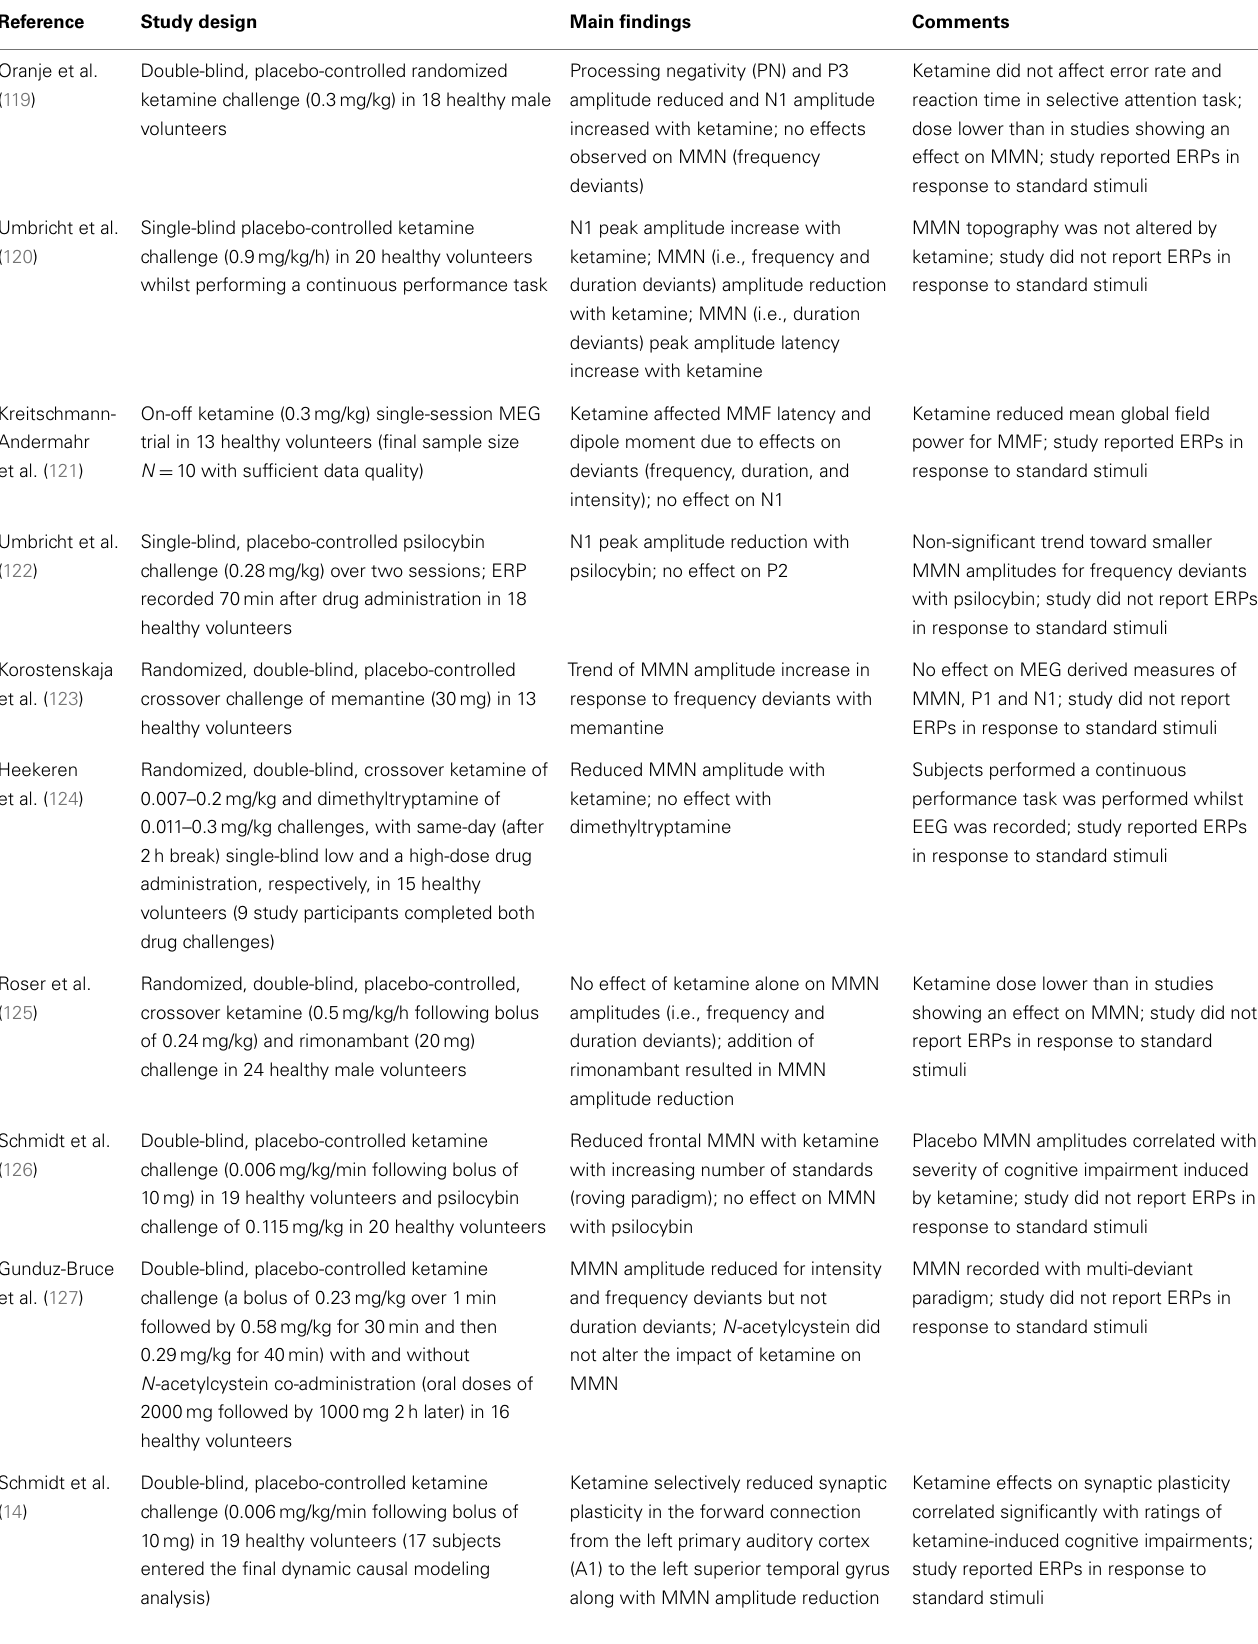
Table 1 | N -methyl-d-aspartate receptor